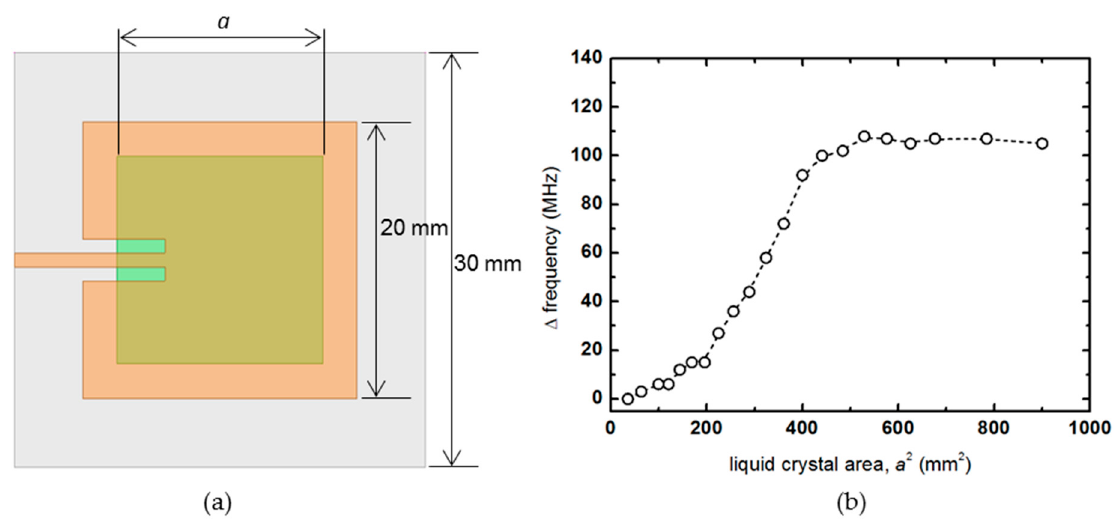
Figure 3. ( a ) Schematic diagram of the patch antenna that increases the liquid crystal area in a square shape, and ( b ) the amount of frequency change.